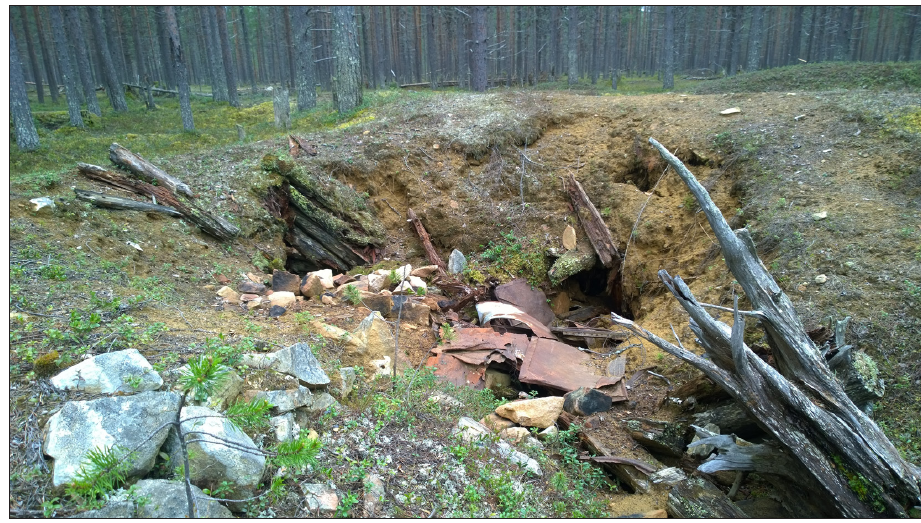
Figure 2: German artillery base, Vuotso, June 2016. (Photo: Eerika